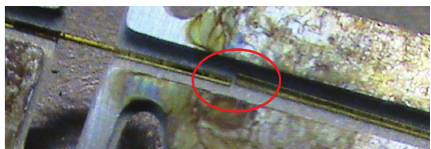
Figure 11: Fiber break at one end of the Bragg grating in the FBG 1